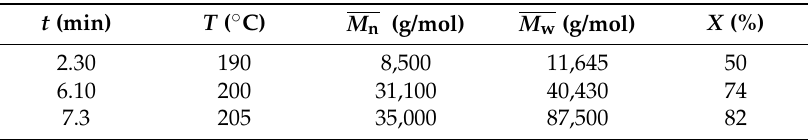
Table 3. Mathematical simulation results for ROP of PLA in batch process.